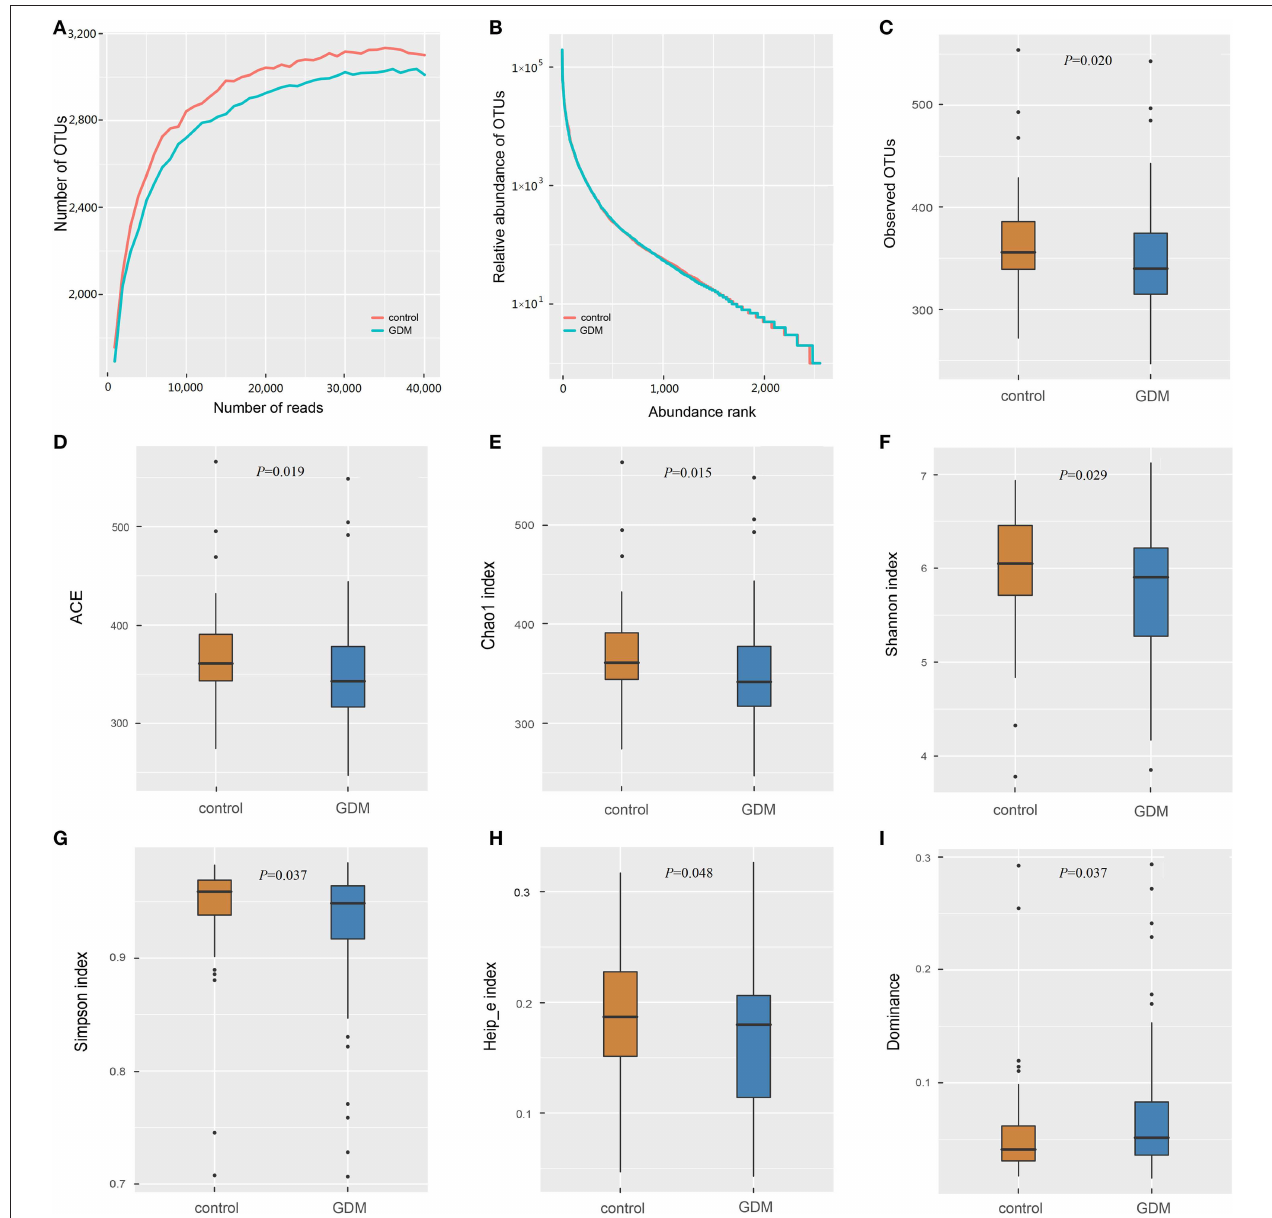
FIGURE 1 | The richness and diversity of the gut microbiota in healthy control and GDM groups. (A) Rarefaction curves to estimate the richness of the gut microbiota in healthy control and GDM groups. The vertical axis shows the number of OTUs expected after sampling the number of tags or sequences shown on the horizontal axis. (B) Rank abundance curves of bacterial OTUs derived from the two groups. Alpha diversity was calculated with QIIME2 software (version 2018.11) based on the sequence similarity at the 100% level, including index of Observed OTUs (C) , abundance-based coverage estimator (ACE, D ), Chao1 estimator (E) , Shannon (F) , Simpson (G) , Heip’s evenness measure (Heip_e, H ) and Dominance (I) . Unpaired t -tests (two-tailed) were used to analyze variation among the two groups, and the P -values are shown in the corresponding figures.